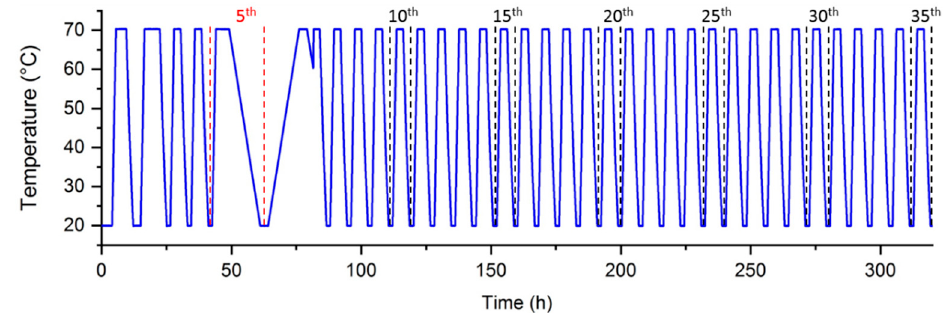
Figure 8. Temperature evolution along the experiment performed on SAT60%.